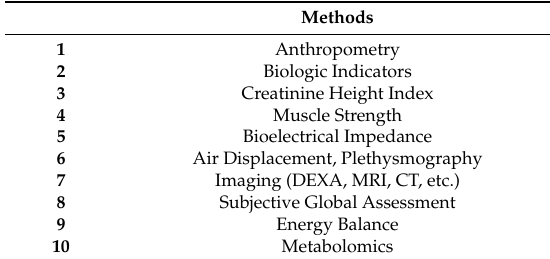
Table 1. Methods of Assessment of